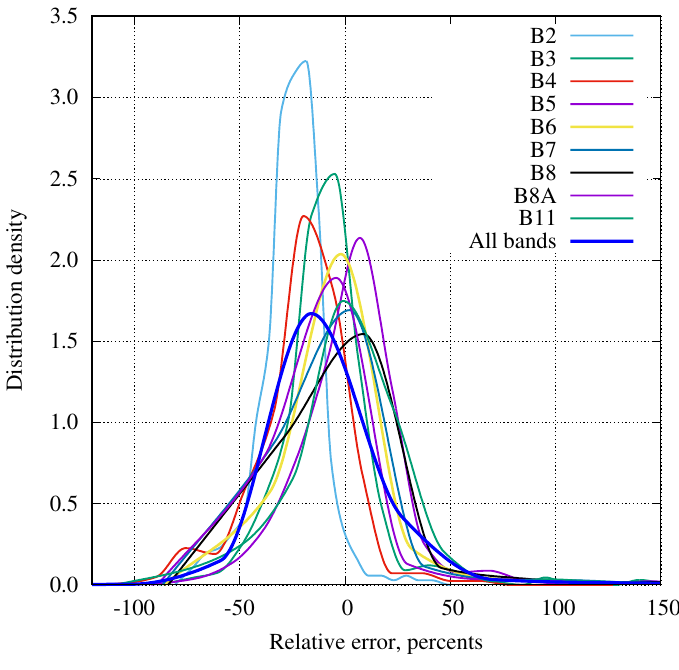
Figure 11. Relative errors of simulated spectra, pine stands.